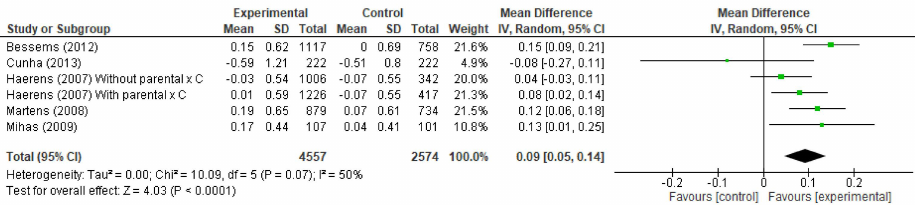
Figure 4. Forest plot of the fruit consumption changes [19,23,24,27,34].